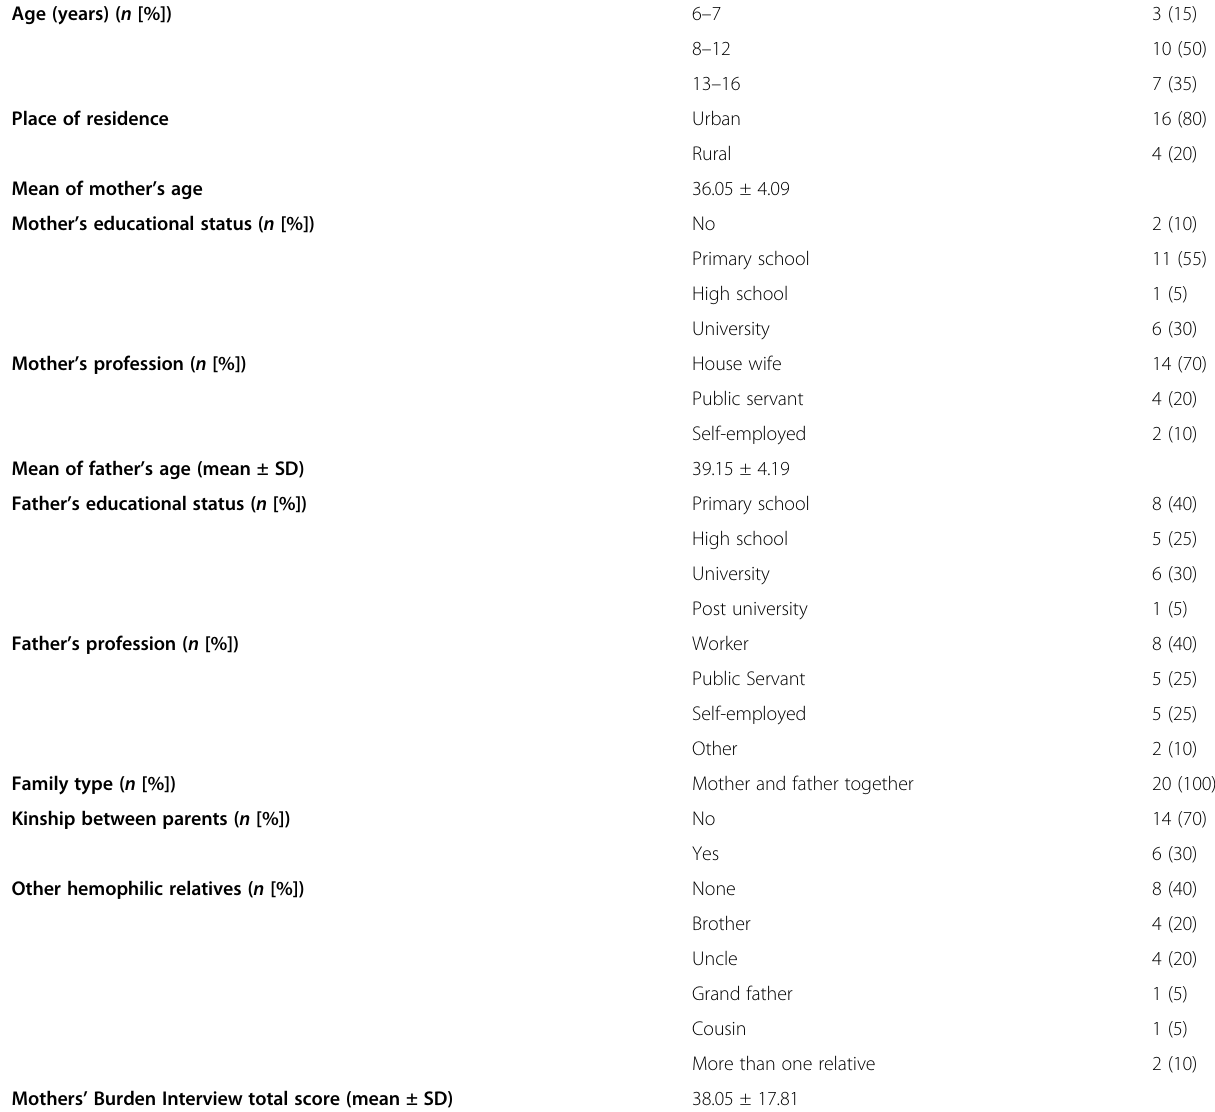
Table 1 Sociodemoghraphic variables of children and adolescents with hemophilia Age (years) ( n